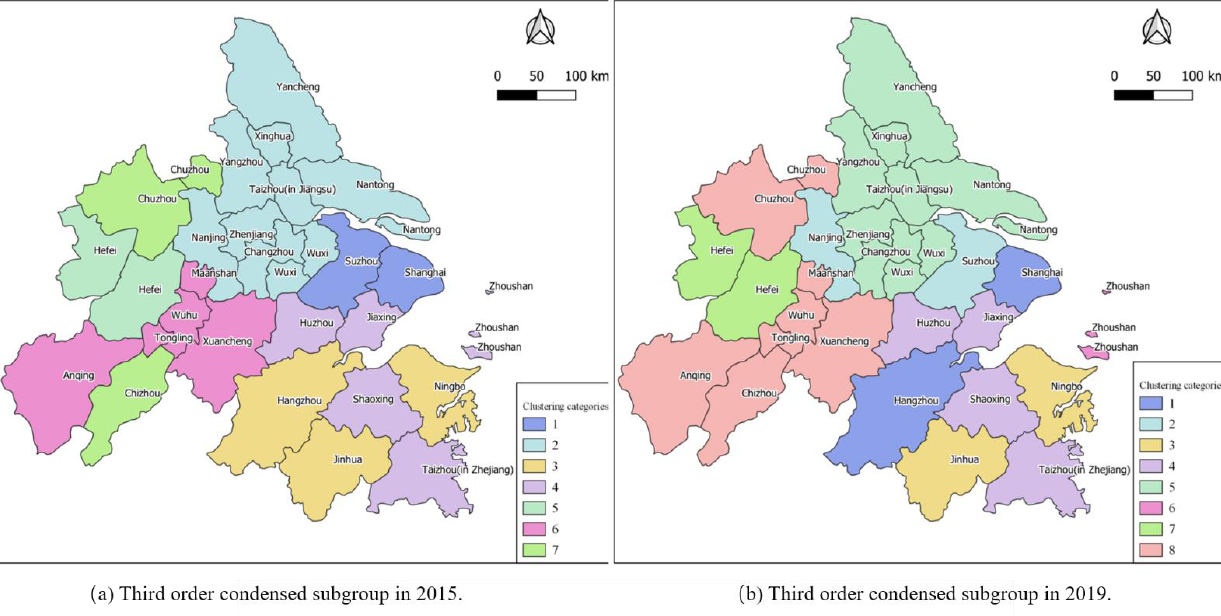
Figure 11. Third order condensed subgroup: (a) 2015; (b) 2019.